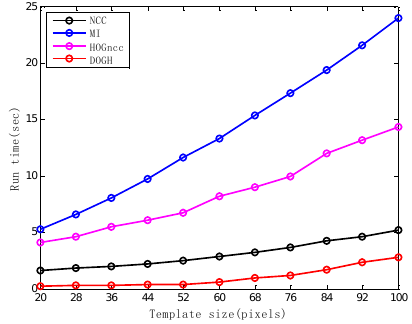
Figure 5 Run time versus the template size to NCC, MI, HOG ncc , and